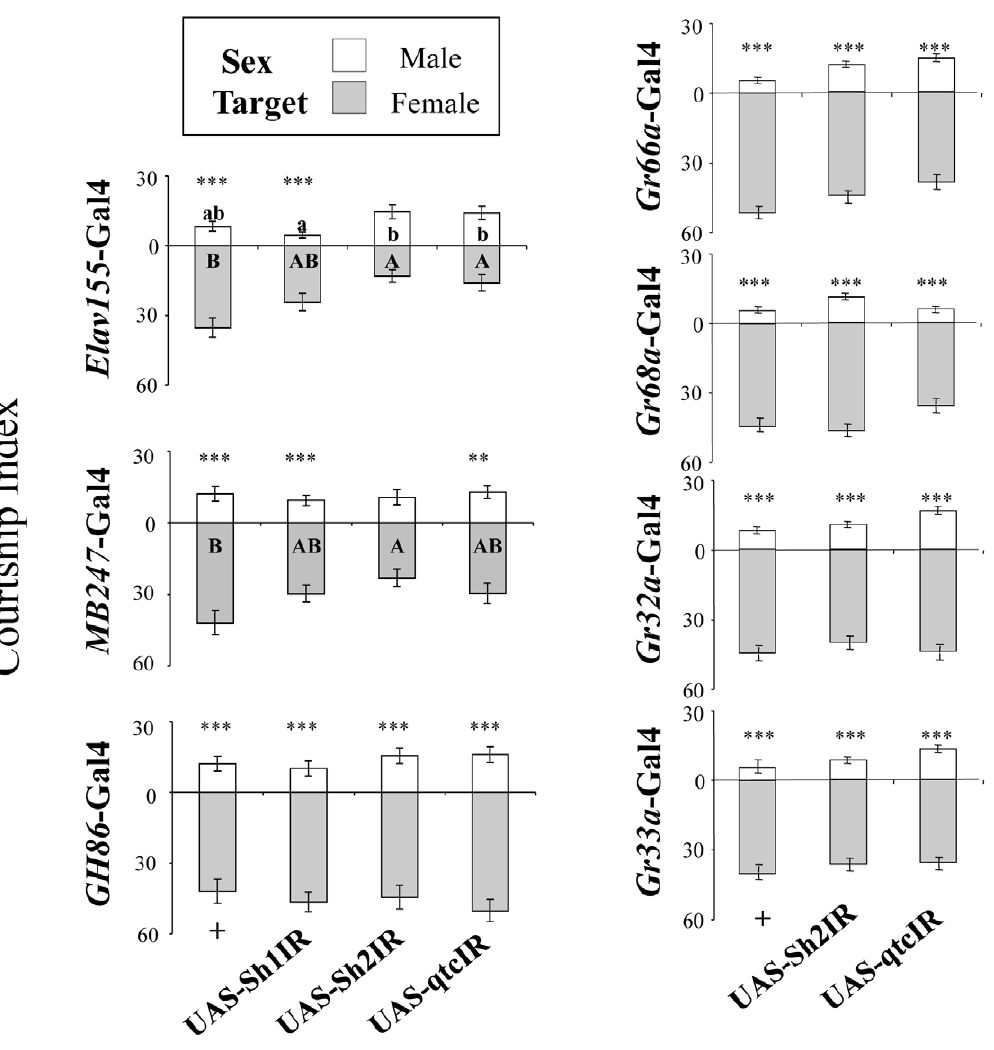
Figure 5. Behavioral effect of the RNAi of the two ‘‘discrimination genes’’ targeted in different subsets of the nervous system. The effect of targeted RNAi expression of the two genes Shaker ( Sh ) and quick-to-court ( qtc ) on males’ ability to discriminate wild-type target males (empty bars) and females (filled bars) was measured. Histograms represent the intensity of courtship directed towards each sex-target. Two RNAi transgenes against Sh ( UAS-Sh1IR , UAS-Sh2IR ) and one RNAi transgene against qtc ( UAS-qtcIR ) were targeted pan-neurally (by Elav155-Gal4 ), in the mushroom bodies ( MB247-Gal4 ), in most peripheral neural sensory neurons ( GH86-Gal4 ; left). UAS-Sh2IR and UAS-qtcIR were also targeted in peripheral taste neurons expressing the Gr66a, Gr68a, Gr32a or Gr33a receptors ( Gr66a-Gal4 , Gr68a-Gal4 , Gr32a-Gal4 , Gr33a-Gal4 ; right). N $ 32. For statistics, see Figs. 2 and 4.